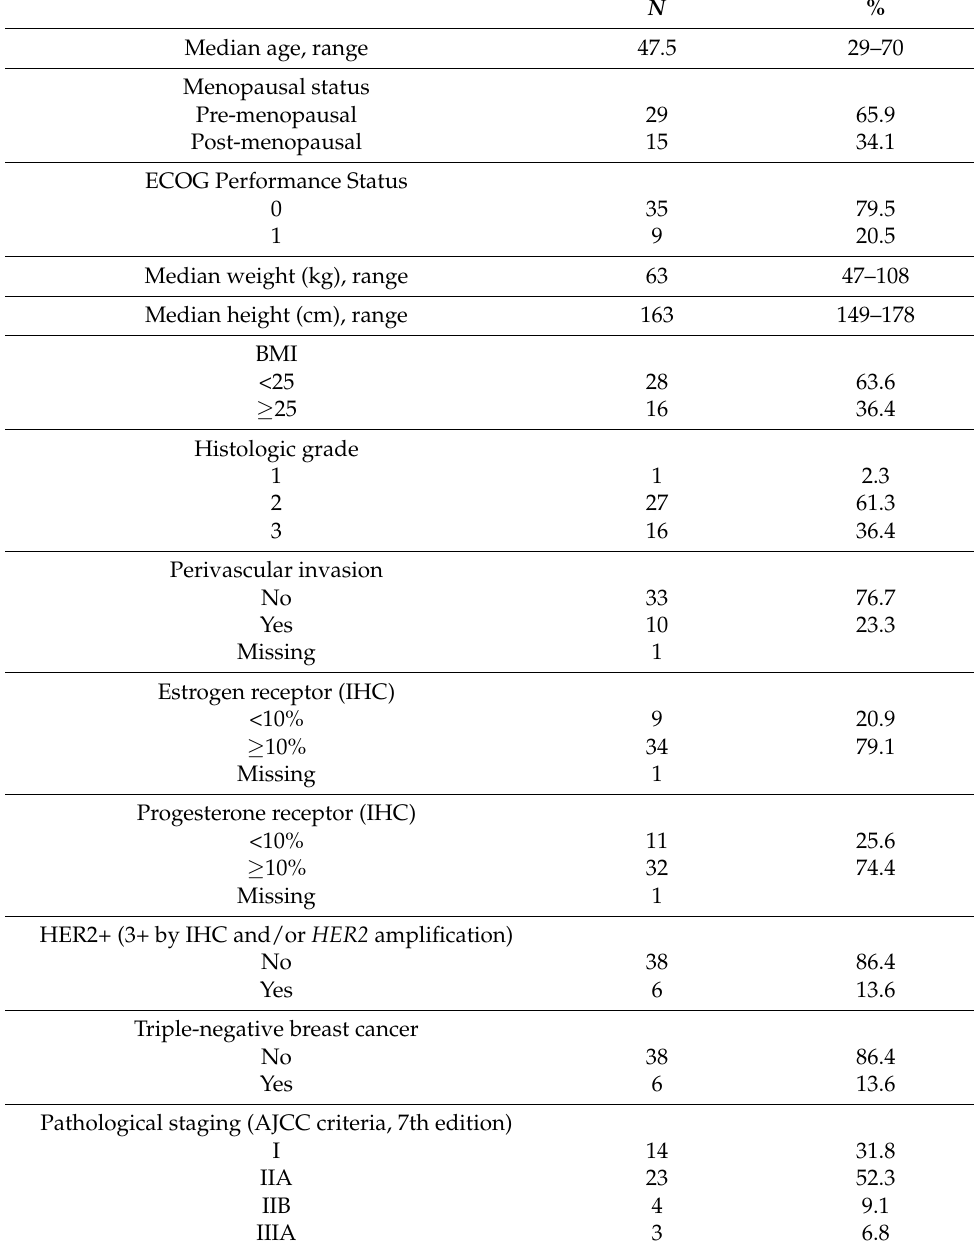
Table 1. Baseline patients’